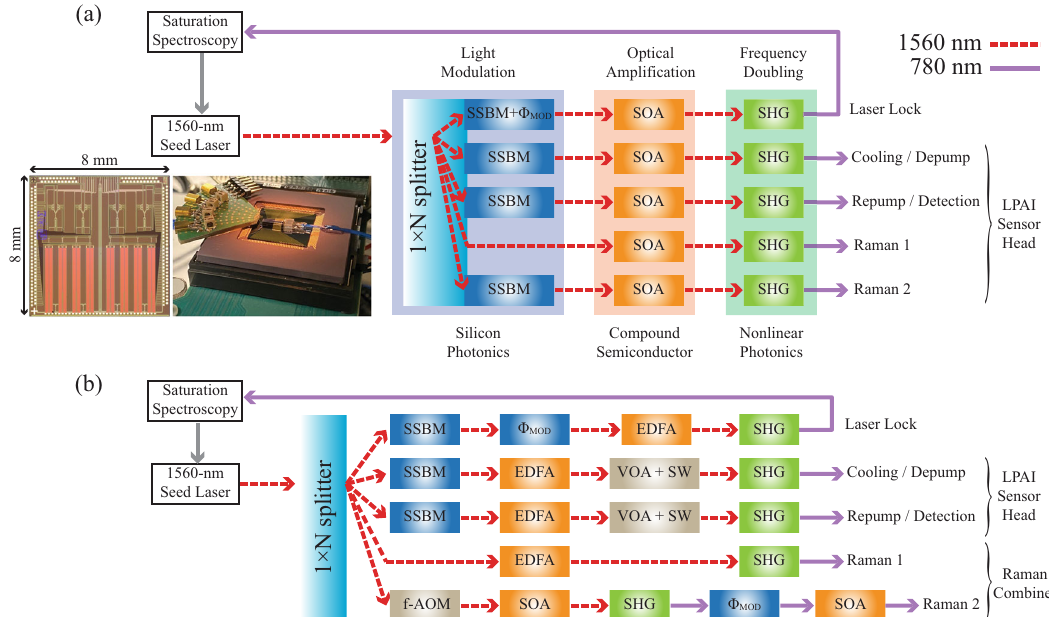
Fig. 4 The laser architecture of the LPAI with a single seed laser and time-multiplexed frequency shifting. a PIC-based laser system composed of silicon photonics for light modulation, compound semiconductor for optical ampli fi cation, and nonlinear photonics for frequency doubling towards a co-packaged laser system and a single hybrid-integrated PIC laser system. (Inset-Left) This image is a four-channel silicon photonic SSBM chip with dual-parallel Mach- Zehnder modulators, simultaneously developed at Sandia 70 . This PIC chip (8 × 8 mm 2 ) includes 17 silicon photonic phase modulators (4 for each SSBM), variable optical attenuators, thermo-optic phase shifters, optical fi lters, and photo detectors. (Inset-Right) This image is a fully packaged silicon photonic SSBM, which has been used to generate the Raman beams from a laser in an LPAI demo 83 . SSBM, single sideband modulator; Φ MOD , phase modulator; SOA, semiconductor optical ampli fi er; SHG, second harmonic generator. Each channel in the silicon photonics includes a VOA to control the amplitude of the light, and an SOA can function as an optical switch. b PIC-compatible laser system based on discrete components used for the data shown in this paper. f-AOM, fi ber-coupled acousto-optic modulator; EDFA, erbium doped fi ber ampli fi er; VOA, variable optical attenuator; SW, optical switch. For Raman 2, we used a f-AOM at 1560 nm and a Φ MOD at 780 nm, which can be replaced with a SSBM at 1560nm similar to the PIC-based laser system. The f-AOM is used for the phase lock by continuously monitoring the beat note between the two Raman beams. Fig. 10 shows the beat note measurement and the switching of the Raman